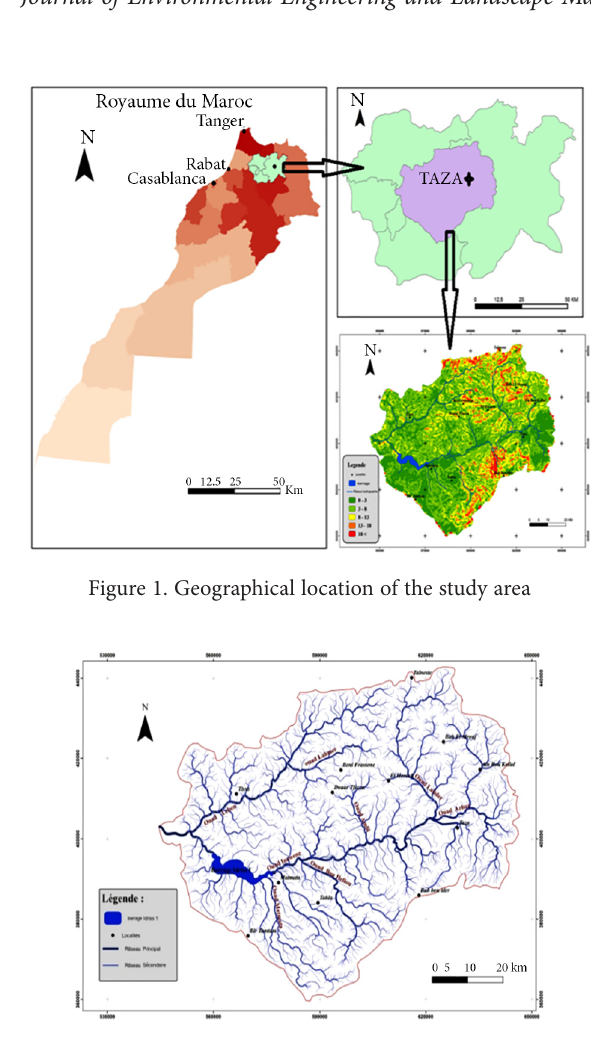
Figure 2. Map of the hydrographic network of the study